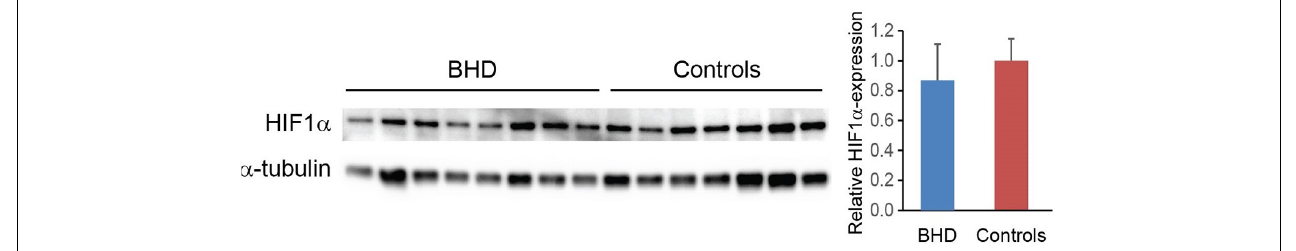
FIGURE 8 | Hypoxia-inducible-factor-1-alpha (HIF1 α ) expression normalized to α -tubulin shows no difference between breath-hold divers (BHD, n = 8) and controls subjects ( n =